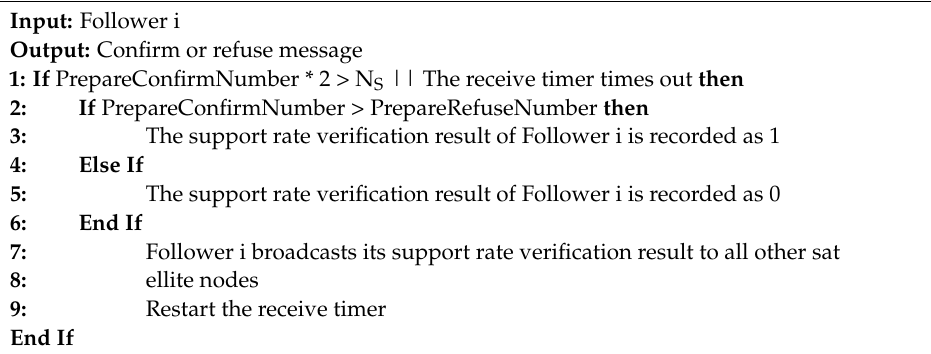
Algorithm 6. The follower support rate verification behavior of the modified PBFT algorithm